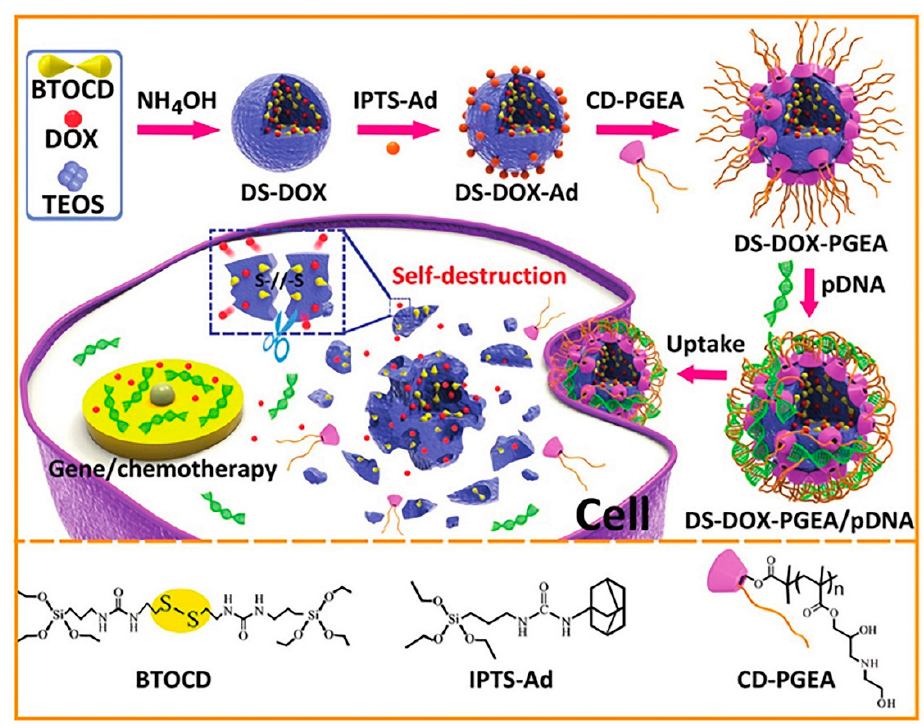
Figure 12. Schematic illustration of the redox-responsive drug/gene co-delivery system. DOX was embedded in a disulfide-silica network, while pDNA was complexed with the polymeric coating, which promoted the self-destruction of the nanosystem and cargo release upon cellular internalization. Adapted from [60], with permission from John Wiley and Sons.